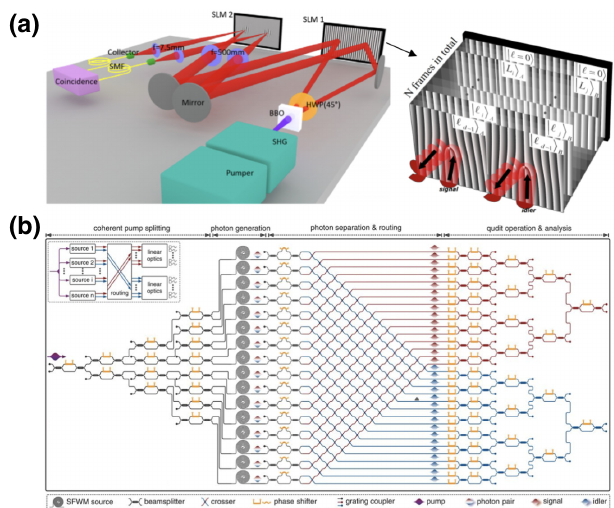
FIG. 3. (a) Experimental arrangement of Zeng et al. [64] to demonstrate high-dimensional steering with the orbital angular- momentum photons. (b) Circuit diagram of the multidimensional silicon quantum photonic circuit in the experiment of Wang et al. [62] to demonstrate high-dimensional steering beyond qubits. Reproduced from (a) Ref. [64], (b) Ref.